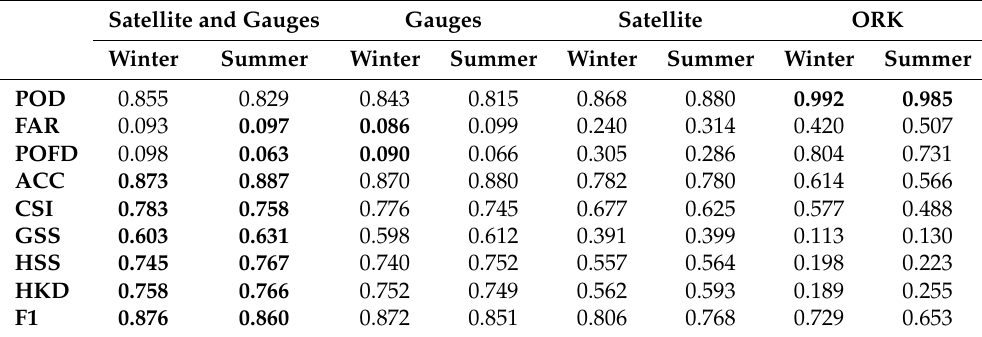
Table 11. Daily precipitation detection scores averaged on the climatological test gauges, for the test days and separating the year into two hydrological seasons. The summer season starts on the 1st of April and finishes on the 30th of September.